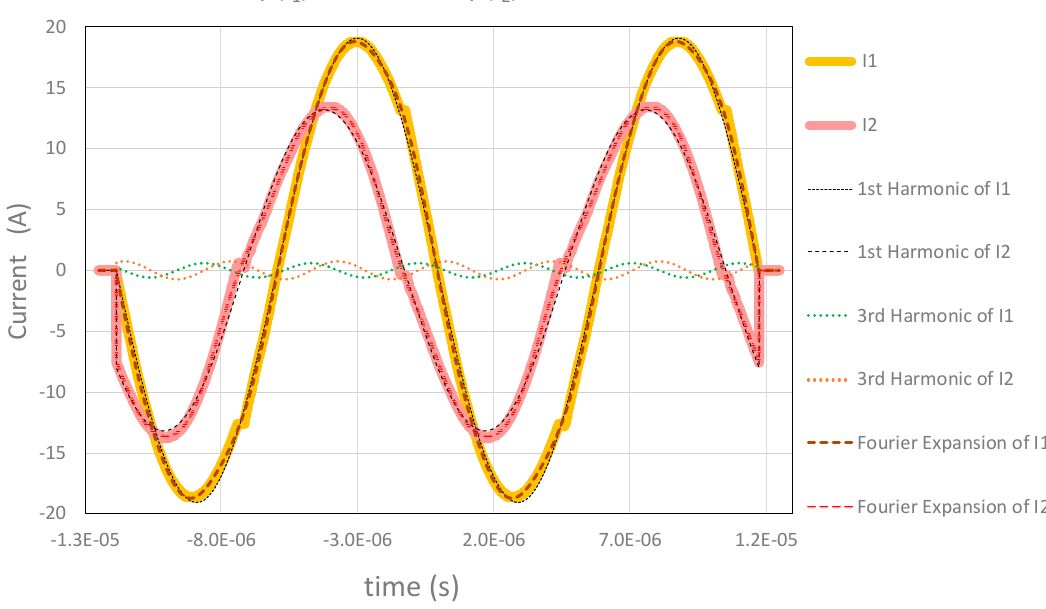
Figure 15. Fourier expansions of measured currents in primary and secondary coils, trunked to the 5th harmonic.